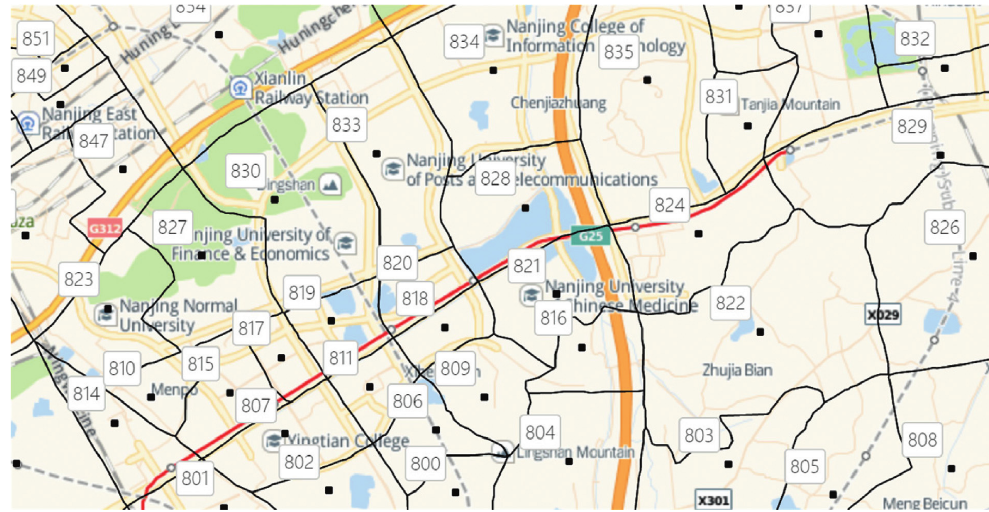
Figure 3: Distribution map of the logistics DPs in the Xianlin